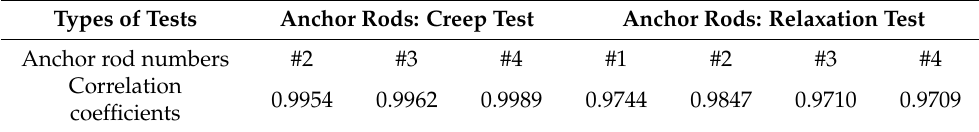
Figure 7. The #2 – #4 anchor rods ’ creep test and prediction curves. Figure 7. The #2–#4 anchor rods’ creep test and prediction curves. Table 2. Correlation coefficient between model test and